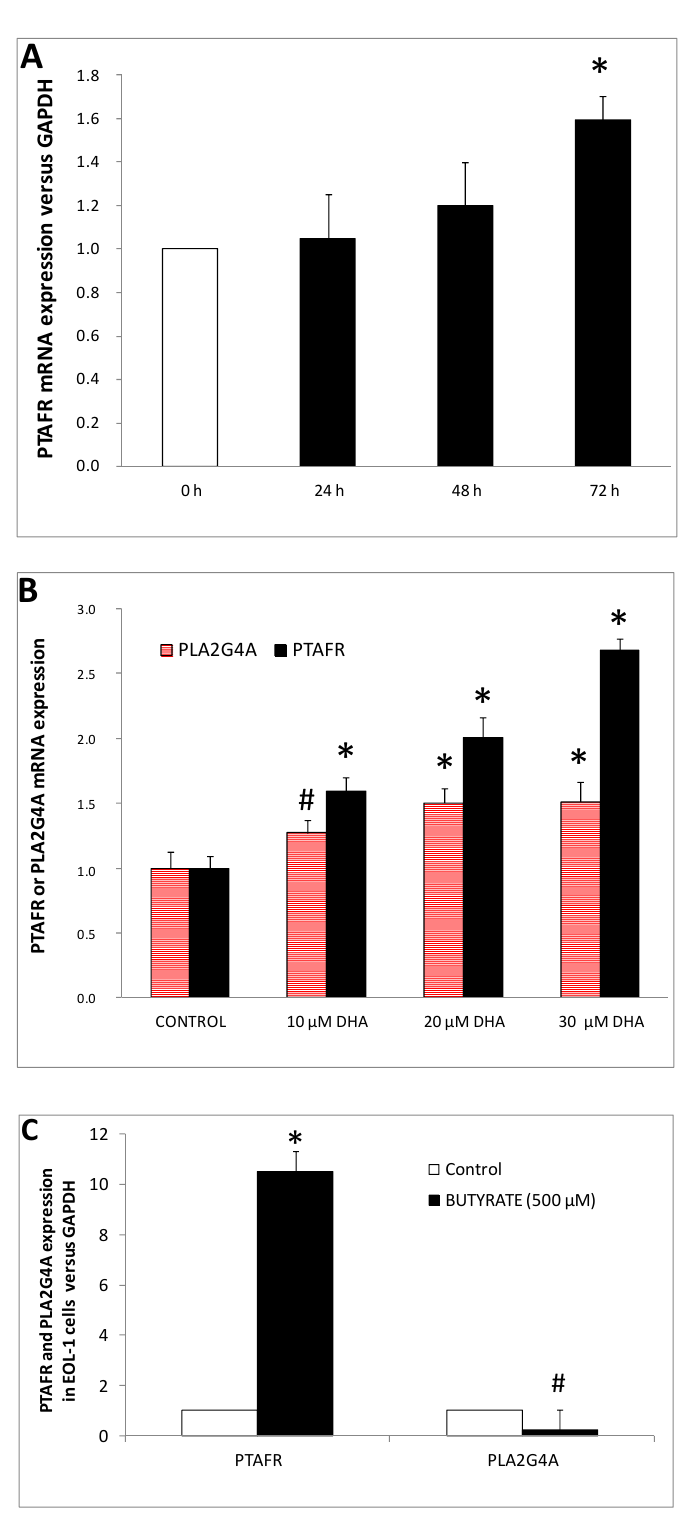
Figure 5. DHA induced PTAFR and PLA2G4A gene expression on EoL-1 cells. ( A ) Time course in DHA (10 µ M) induced PTAFR mRNA expression ( n = 4, in triplicates). ( B ) The levels of PTAFR and PLA2G4A mRNA expression were measured after 3 days ( n = 3, in duplicates) of treatment with 10, 20 and 30 µ M DHA. ( C ) Butyrate induced expression of PTAFR and PLA2G4A -mRNA ( n = 3, in duplicates). The symbols # and * denote statistically significant difference of p < 0.05 and p < 0.01, respectively as compared to control. t -Test analysis for independent samples was applied by Statistica